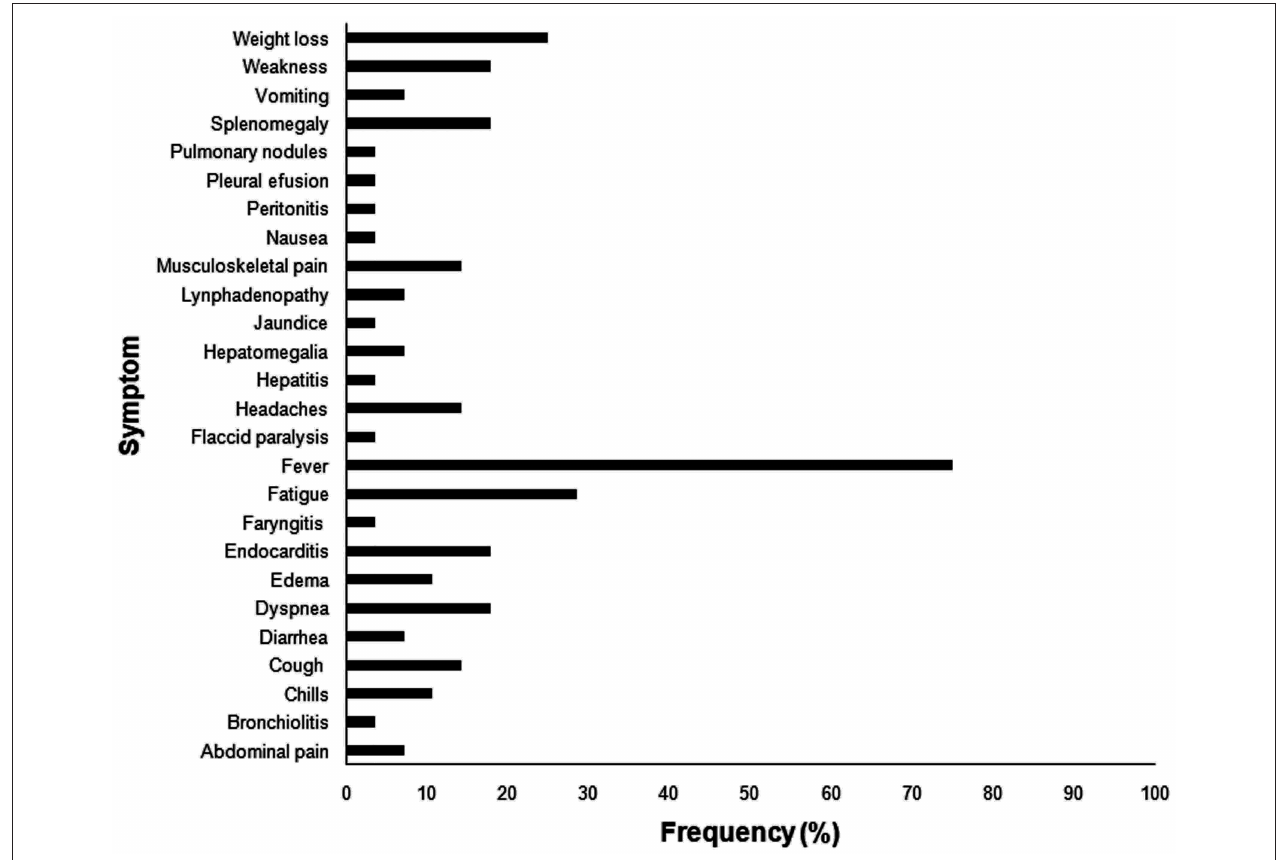
FIGURE 2 | Frequency of symptoms reported in human brucellosis caused by Brucella canis . *All references used in the figure are listed in Supplementary Table 1